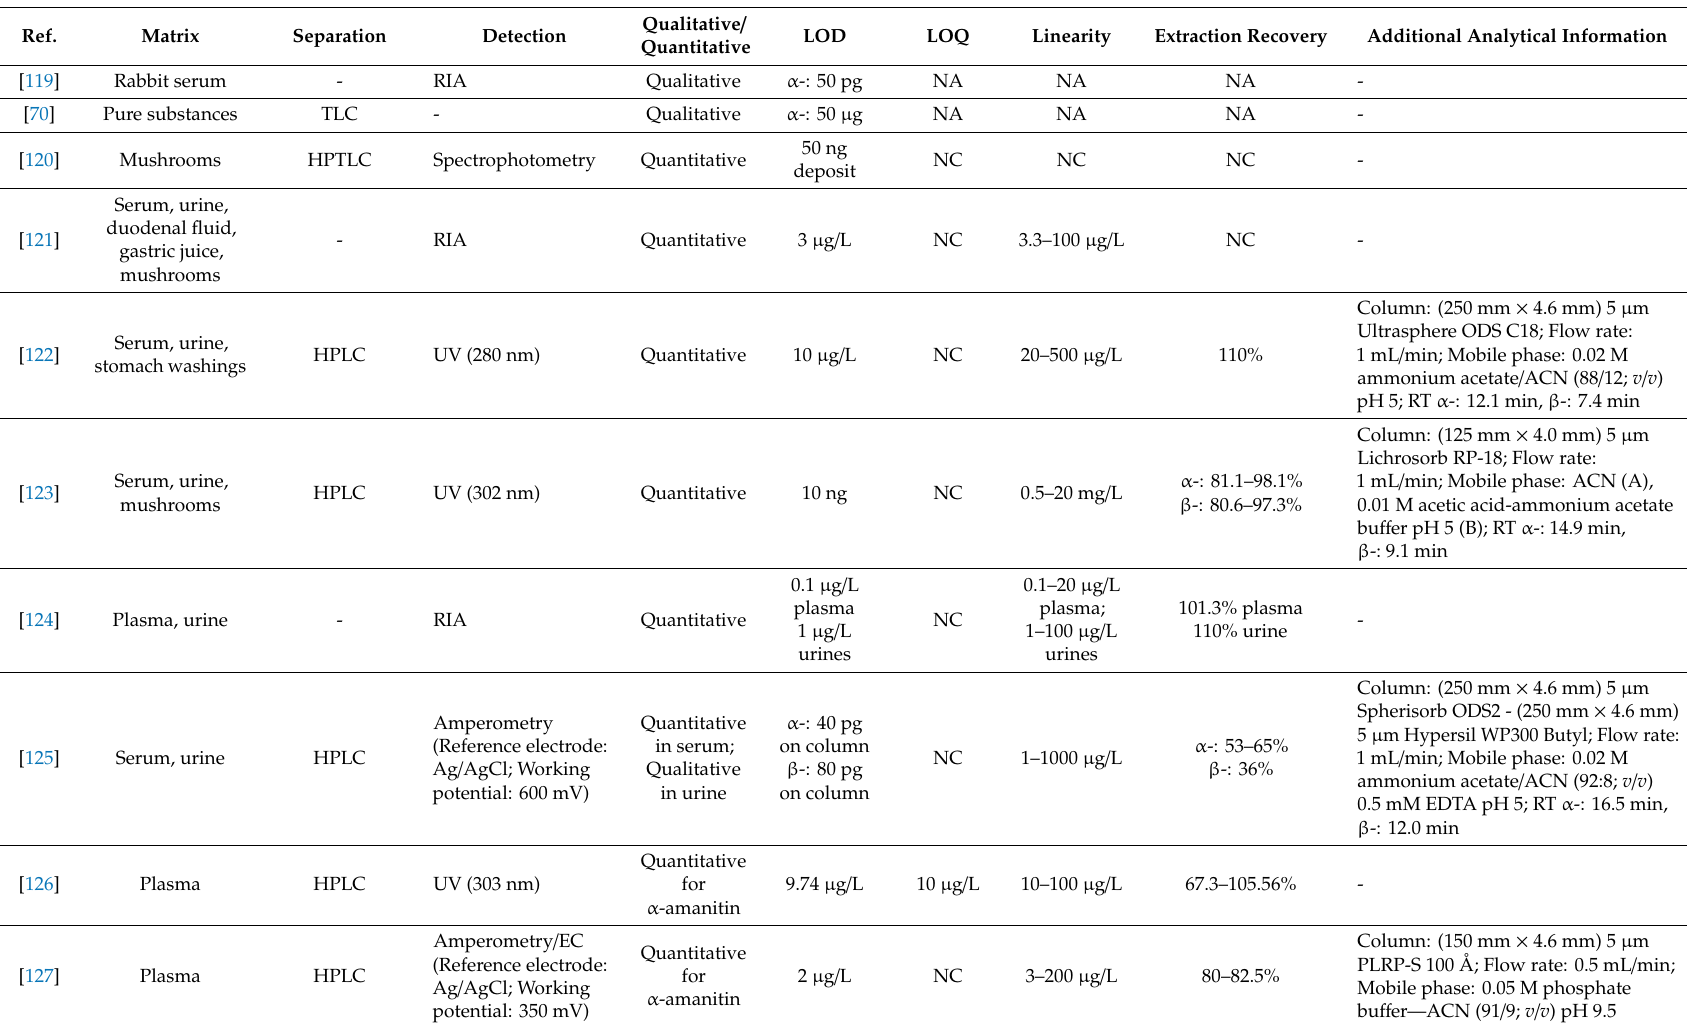
Table 4. Analytical methods for amatoxins